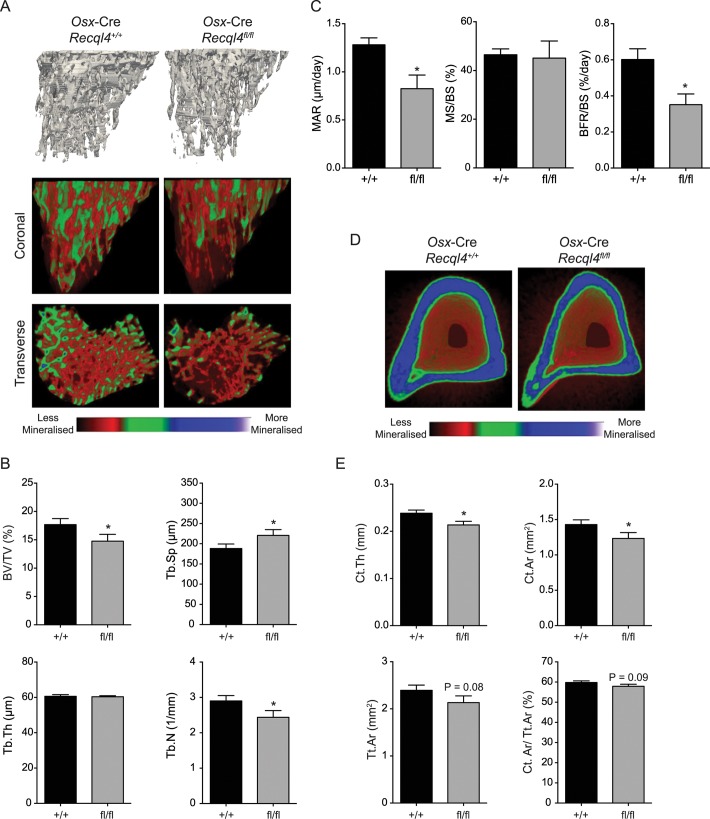

Osx-Cre Recql4
fl/fl mice have a low bone mass.(A) Representative images of reconstructed trabecular region of the proximal tibial secondary spongiosa (top) and color-coded quantitative mineralization images (bottom) from male Osx-Cre Recql4
+/+ and Recql4
fl/fl mice. (B) Trabecular bone volume (BV/TV), trabecular separation (Tb.Sp), trabecular number (Tb.N), trabecular thickness (Tb.Th) of Osx-Cre Recql4 tibiae. n≥ 8 for both genotypes. (C) Mineralization apposition rate (MAR), mineralizing surface per unit bone surface (MS/BS) and bone formation rate per unit bone surface (BFR/BS) from the dynamic histomorphometric analysis of the proximal tibial secondary spongiosa. n = 5–6 for both genotypes. (D) Representative images of reconstructed cortical bone with colour-coded quantitative mineralisation from Osx-Cre Recql4
+/+ and Recql4
fl/fl mice. (E) Cortical thickness (Ct.Th), cortical bone area (Ct. Ar), total cortical cross-sectional bone area (Tt.Ar) and cortical bone area fraction (Ct.Ar/Tt.Ar) of Osx-Cre Recql4 cortical tissue. n≥ 8 for both genotypes. Data presented as mean±SEM. *P<0.05, compared with Recql4
+/+, t-test.